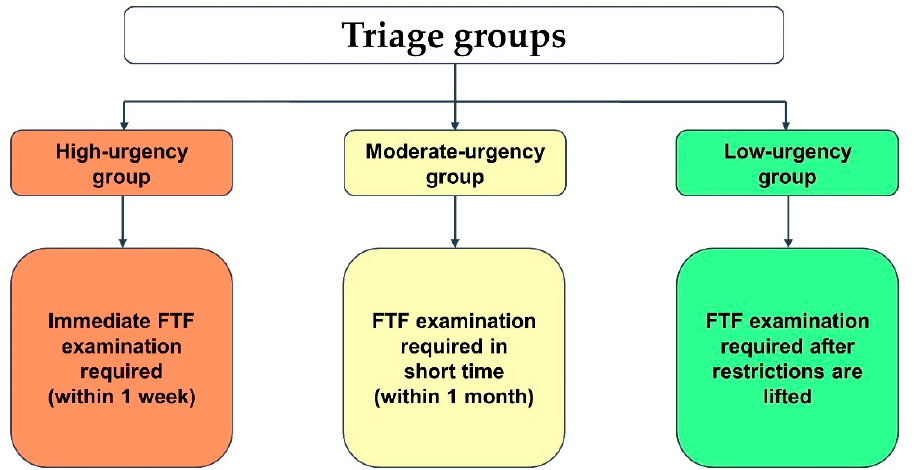
Figure 1. Definition of the triage groups. Abbreviations: FTF, face-to-face.